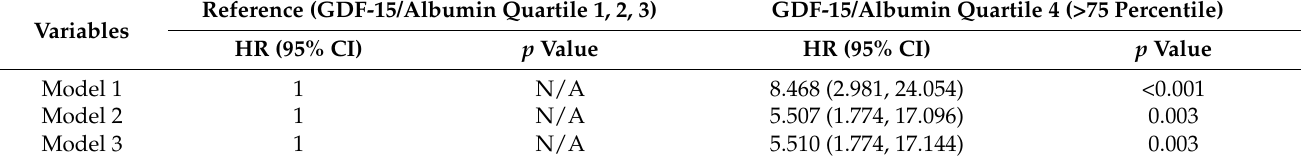
Table 3. Association of GDF-15/albumin ratio and all-cause mortality by Cox proportional haz- ard